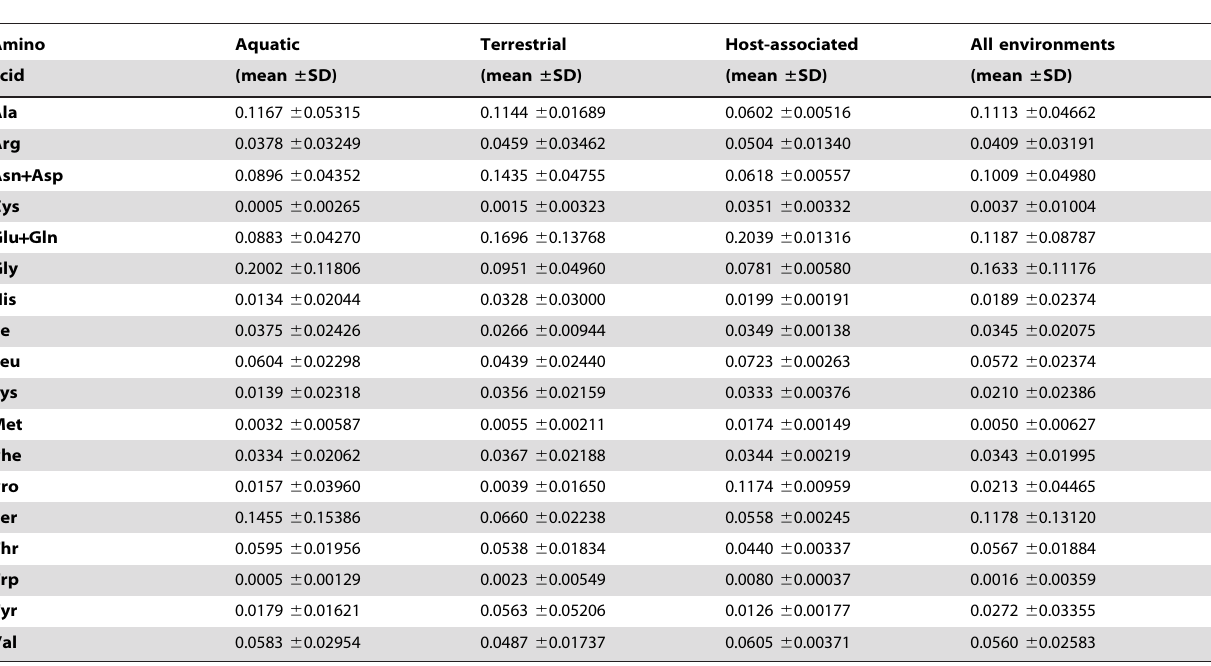
Table 1. Average environmental relative amino acid abundance (eRAAA) across habitats calculated from the literature.